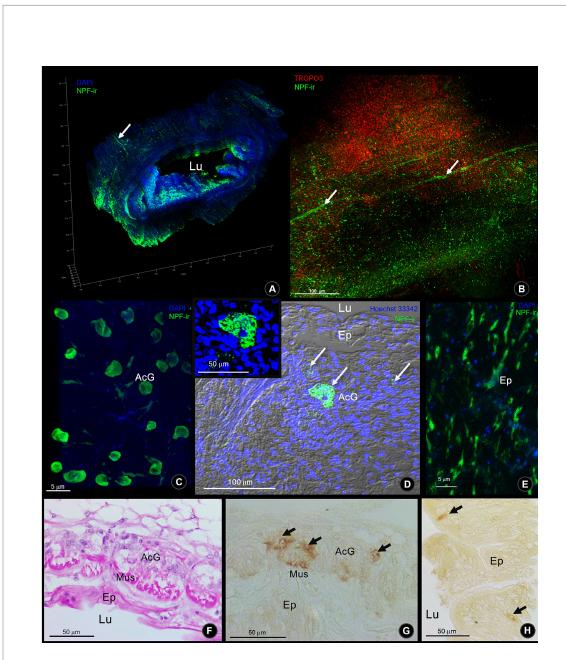
FIGURE 4 The Macro -NPF-ir detection in the intestine of S. olivacea. (A) Wholemount immuno fl uorescence of NPF-ir (green) counter- stained with DAPI revealed the overview of their localization. (B) The outer surface of intestinal serosa presented the NPF-ir in longitudinal nerve fi bers. (C) Deep to the outer connective tissue, NPF-ir was localized in acinar glandular cells (arrows), revealed by wholemount immuno fl uorescence, and (D) by immuno fl uorescence in tissue section. (E) The NPF-ir localization presented in the spindle-shaped epithelial cells. (F) H&E staining of longitudinal section and (G) NPF-ir detection by immunohistochemistry (HRP detection) presented in acinar glandular cells of the subepithelial connective tissue layer (arrows). (H) Immunohistochemistry showed the positive signal of NPF localization in spindle-shaped epithelial cells (arrows).